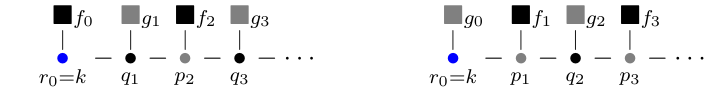
(c) The left quiver corresponds to the brane setup of (cid:12)gure 5a (O8 + -O6 (cid:0) combined projection), the right one to that of (cid:12)gure 5b (O8 (cid:0) -O6 + combined projection). Notice that we have added possible